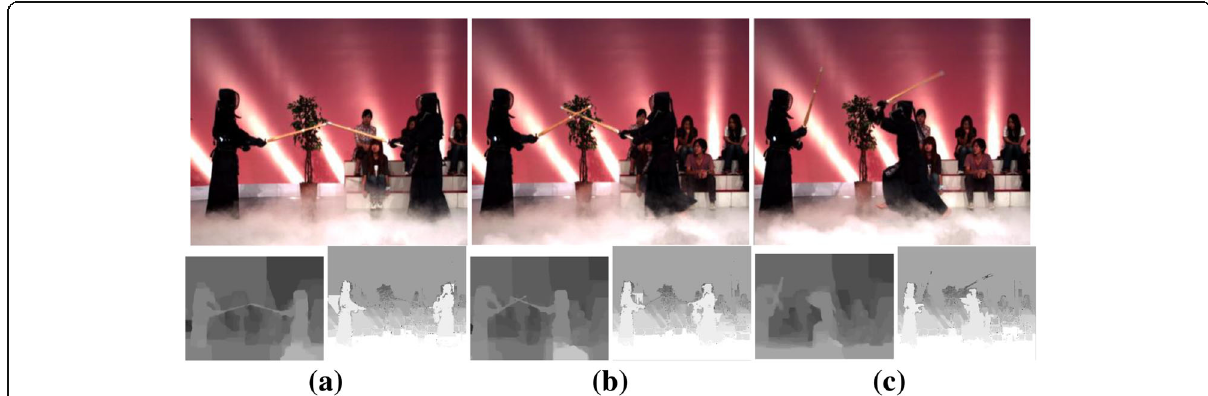
Fig. 13 Comparisons of depth maps in Kendo sequence. a Frame 1. b Frame 16. c Frame 25. Images from upper, left to right are original images, ground truth, and depth maps of the proposed